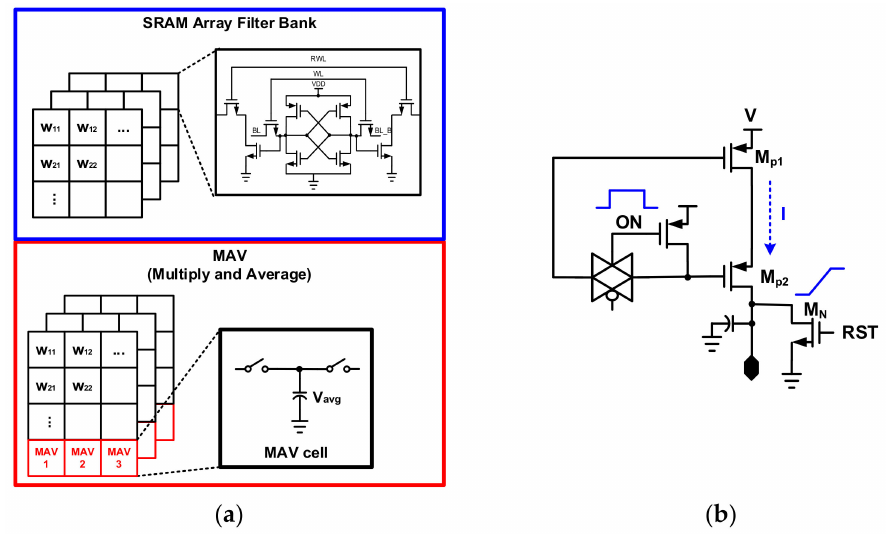
Figure 6. A detail structure of the analog processor-in-memory: ( a ) 10T based 4 × 4 size SRAM cell and MAV operation; ( b )voltage charger with charge sharing structure used in